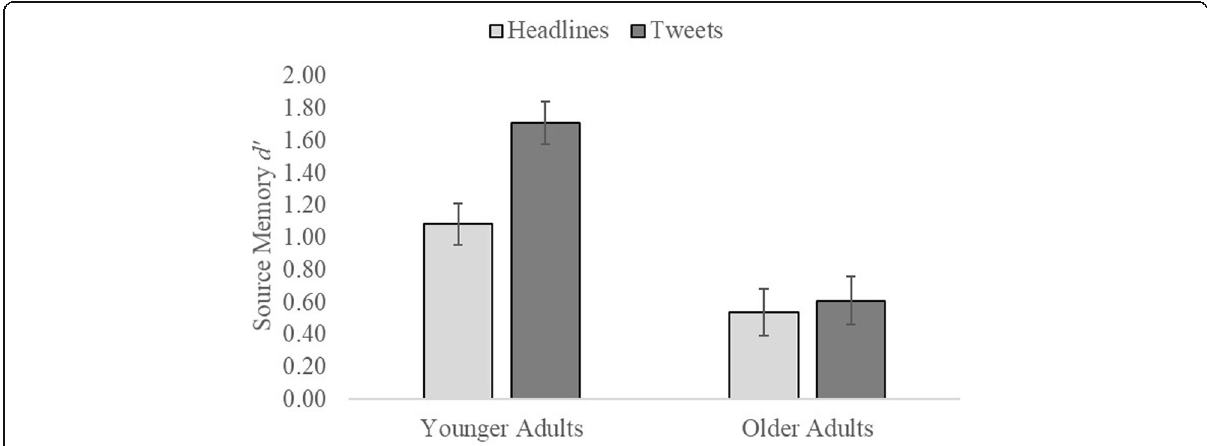
Fig. 2 Source memory d ’ as a function of item content (headlines versus tweets) and